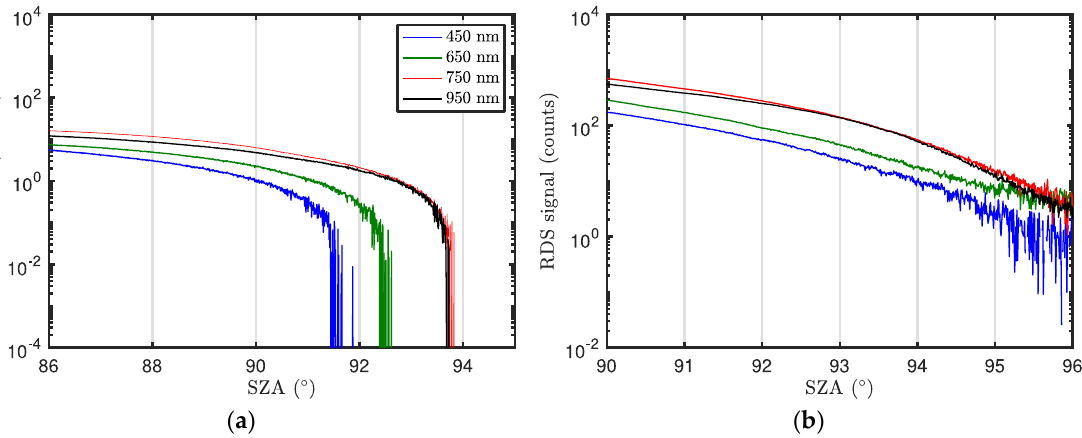
Figure 25. ( a ) RDS TOP-4 (450 nm), TOP-5 (650 nm), TOP-6 (750 nm), and TOP-8 (950 nm) measurements at twilight. ( b ) Same as left panel but using the second gain factor.